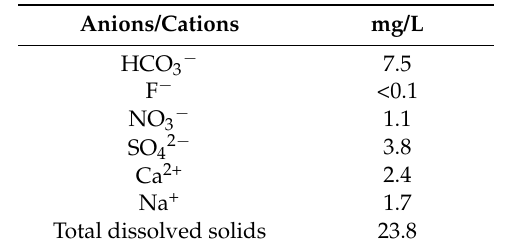
Table 1. Composition of water utilized for tea infusion, expressed as mg of anion or cation dissolved in 1 L of